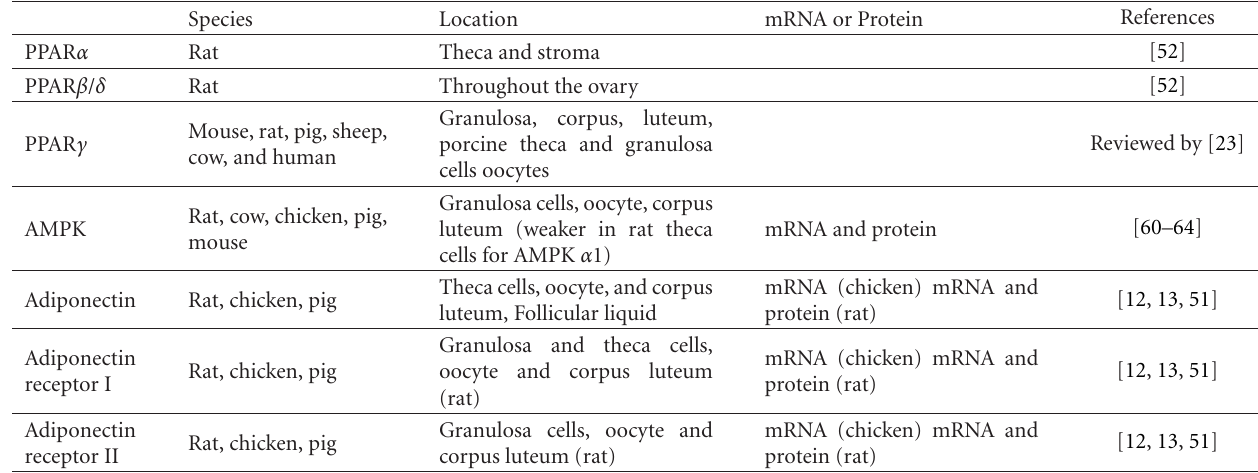
Table 1: Location of PPARs, AMPK, and adiponectin in